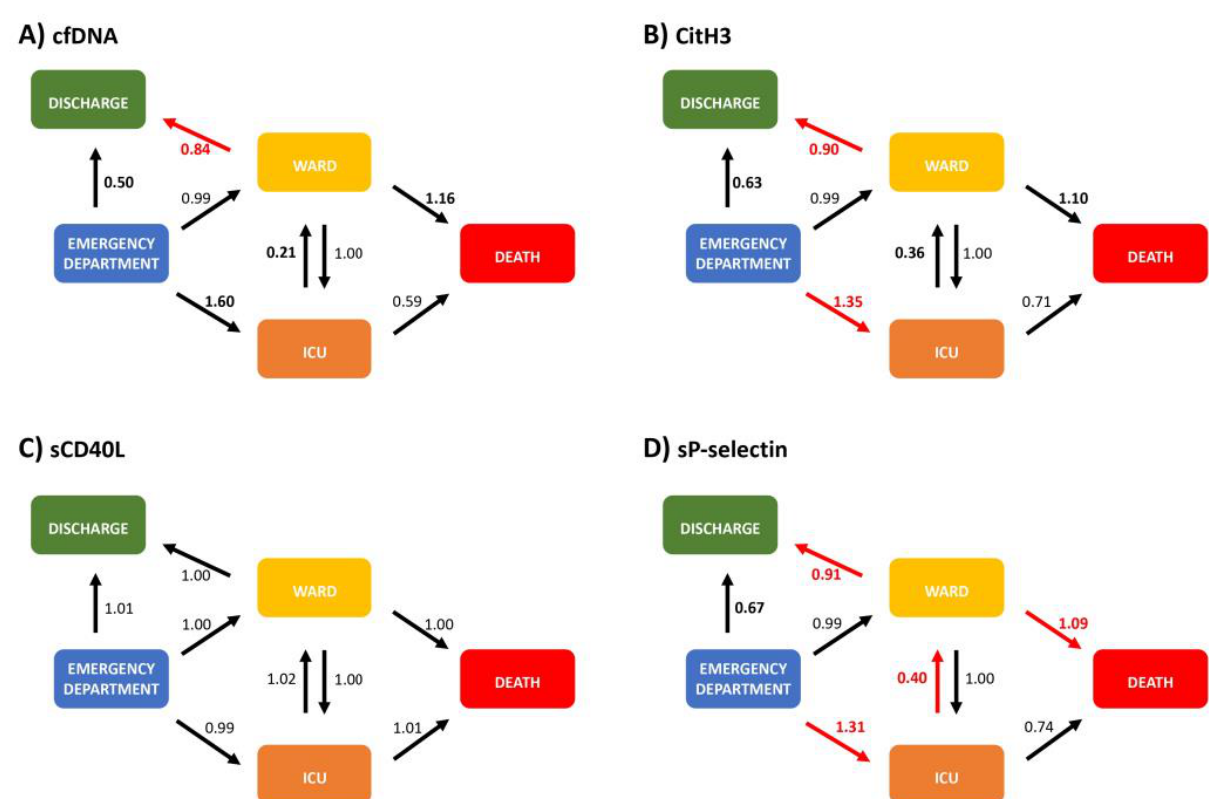
Figure 4. Multistate model for neutrophil extracellular trap and platelet activation markers. Evalu- ated states were: emergency department (ED) visit, ward admission, intensive care unit (ICU) ad- mission, death and hospital discharge (outpatient). ( A ) cfDNA model. ( B ) CitH3 model. ( C ) sCD40L model. ( D ) sP-selectin model. Arrows show the transitions among states. We show hazard ratios (HR) next to the arrows and represent the increase by one standard deviation above the biomarker level mean. Red arrows and HR indicate statistically significant transitions. HR in bold denotes trends/proximity to statistical significance. Table S2 details 95% confidence intervals. For further explanation, please see text.